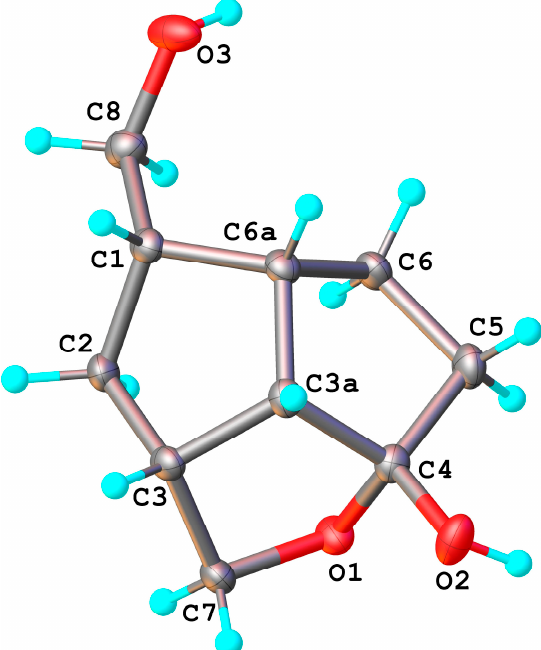
Figure 6. X-ray molecular structure of the un-symmetrical ketone, as internal hemiketal compound 15 (molecule B ). Thermal ellipsoids are drawn at 50% probability level.